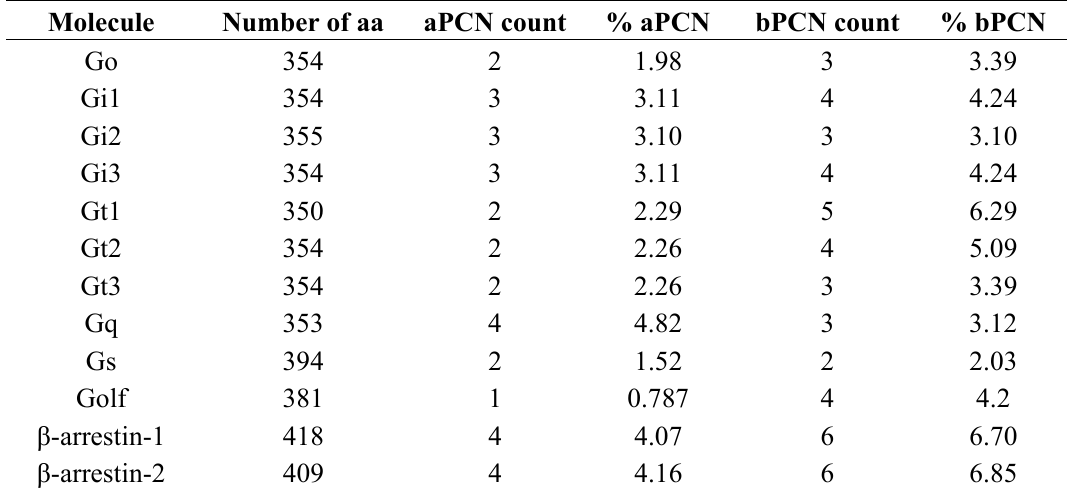
Table 1. Comparison of homoionic clusters in G-protein α subunits and β